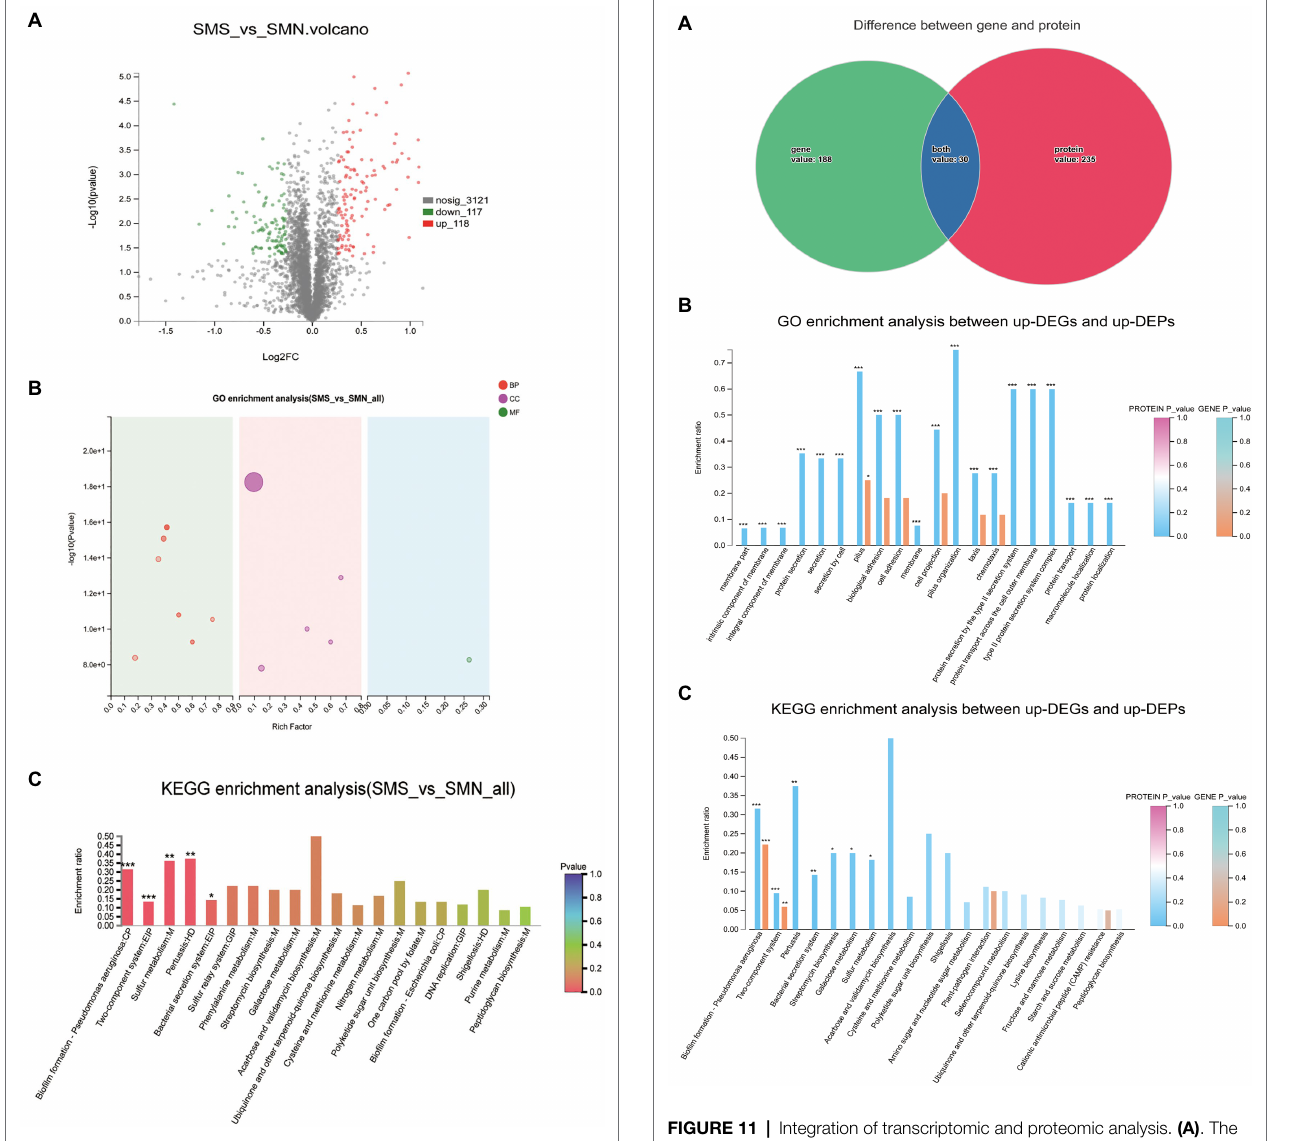
FIGURE 10 | Comparative proteomic analysis. (A) . Differentially expressed proteins (DEPs) between SMS and SMN. The X-axis is the fold change value of the difference in the protein expression between the two groups. The Y-axis is the statistical test value of the DEPs. The value of abscissa and ordinate have been logarithmized. Each point in the figure represents a specific protein. The green points are downregulated proteins and red points represent upregulated proteins. (B) . GO enrichment analysis of SMS and SMN. The X-axis is the rich factor. The Y-axis is -log10 ( value of p ). Each bubble in the figure represents a secondary GO category. The size of the bubble is directly proportional to the number of concentrated proteins enriched in this GO secondary classification (BP, biological process; CC, cellular component; and MF, molecular function). (C) . KEGG enrichment analysis of DEPs between SMS and